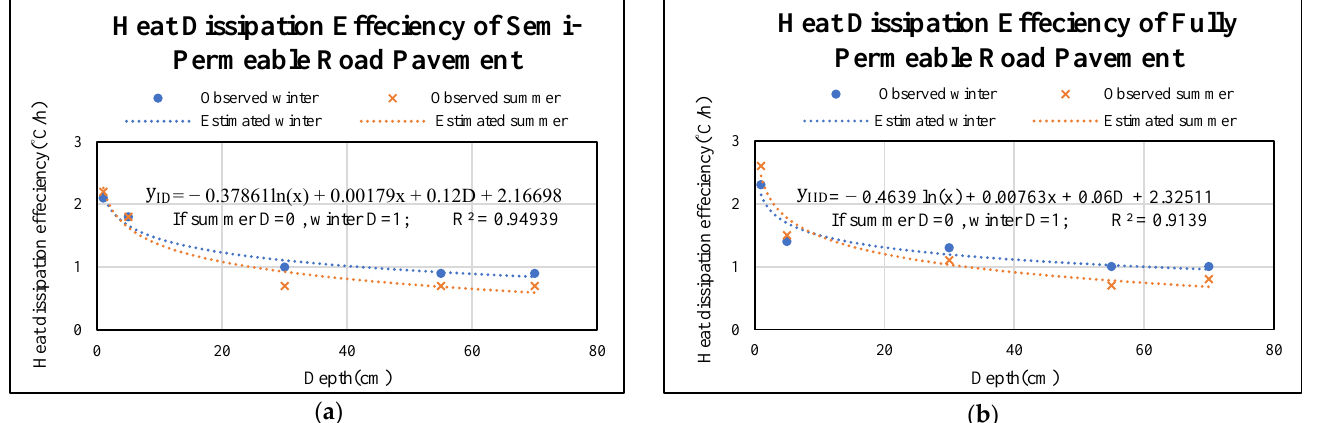
Figure 9. Relationships between heat dissipation efficiency verse permeable road pavements depth ( a ) Model for semi- permeable road pavement. ( b ) Model for fully permeable road pavement.